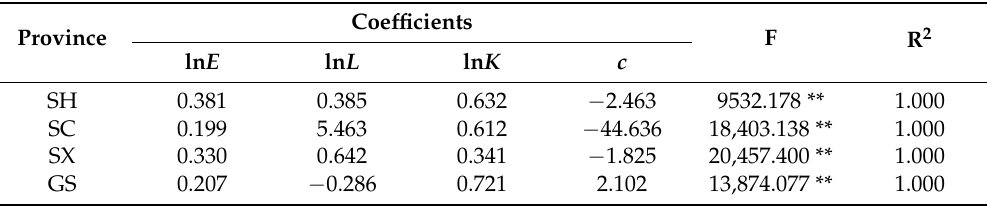
Table 6. Results of regression analysis based on Cobb-Douglas production function.